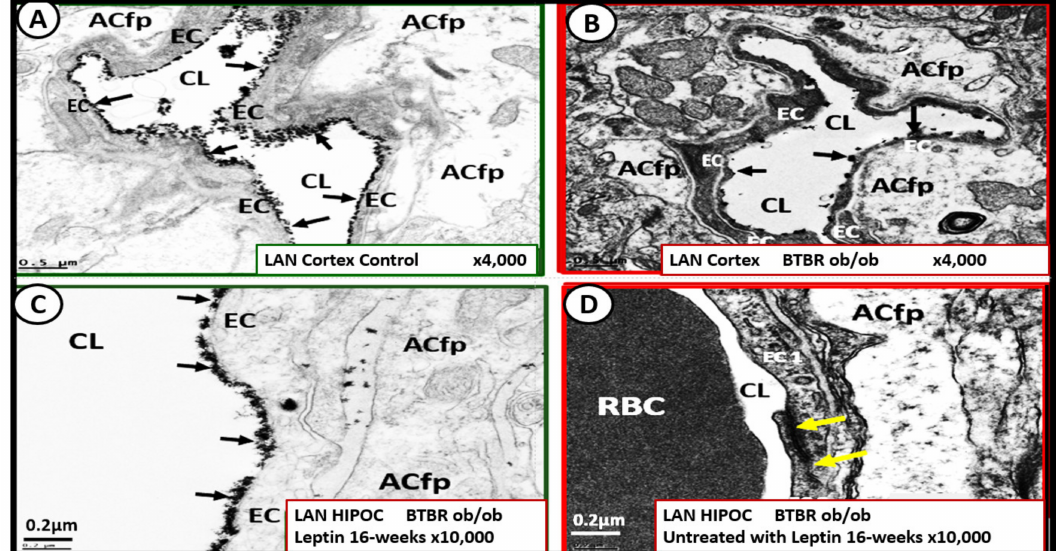
Figure 18. Leptin replacement in the obese diabetic BTBR ob/ob protects the brain endothelial cell glycocalyx (ecGCx) in cortical layer III and hippocampus. Panel A demonstrates the continuous decoration of the ecGCx with lanthanum nitrate (LAN) staining in the heterozygous non-diabetic control model cortical layer III (arrows). Panel B depicts the marked attenuation and/or loss of the ecGCx in the obese diabetic BTBR ob/ob model cortical layer III and note when the ecGCx was present it was clumped and discontinuous (arrows). Panel C also demonstrates the continuous decoration of the ecGCx in hippocampus CA-1 regions of the BTBR ob/ob models that were treated with intraperitoneal leptin for 16-weeks and stained with LAN (arrows) and the ecGCx is comparable to the control model in panel A and that the ecGCx is continuous. Panel D depicts the complete loss of the ecGCx by LAN staining in the hippocampus CA-1 regions of the BTBR ob/ob and note that the tight and adherens junction (TJ/AJ) remain intact (yellow arrows). The loss of the first barrier of the tripartite BBB may result in increased permeability. Images provided by CC 4.0 [52]. Magnification × 4000; scale bar = 0.5 µ m in panels A and B . Magnification × 10,000; scale bar = 0.2 µ m in panels C and D . ACfp = astrocyte foot process; Cl = capillary lumen; BEC = brain endothelial cell; HIP and HC = hippocampus CA-1